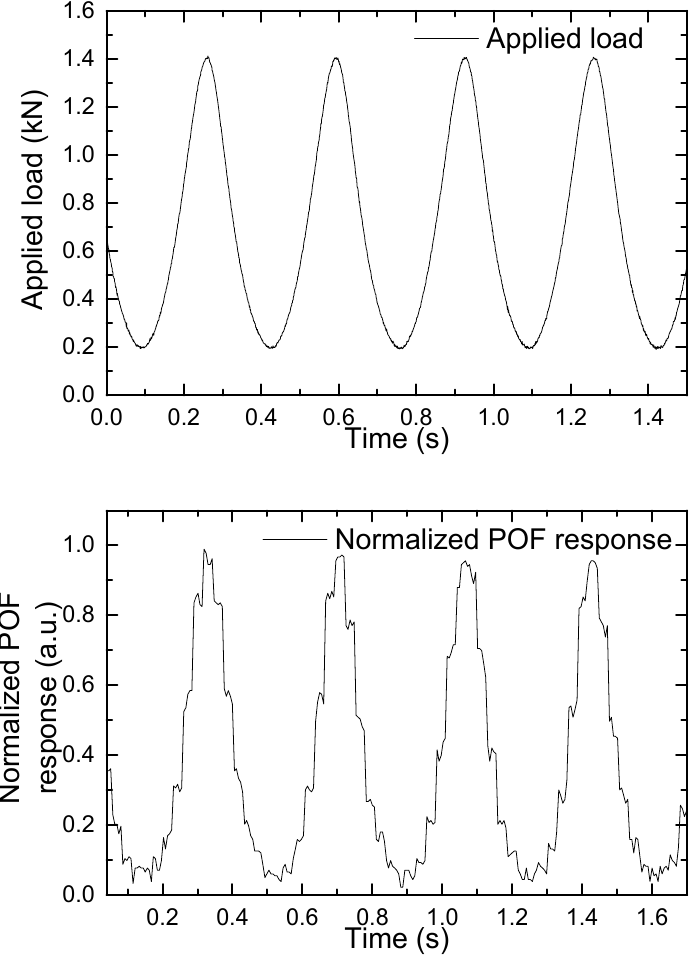
Figure 11. Applied load and normalized POF response that simulate a running pattern.